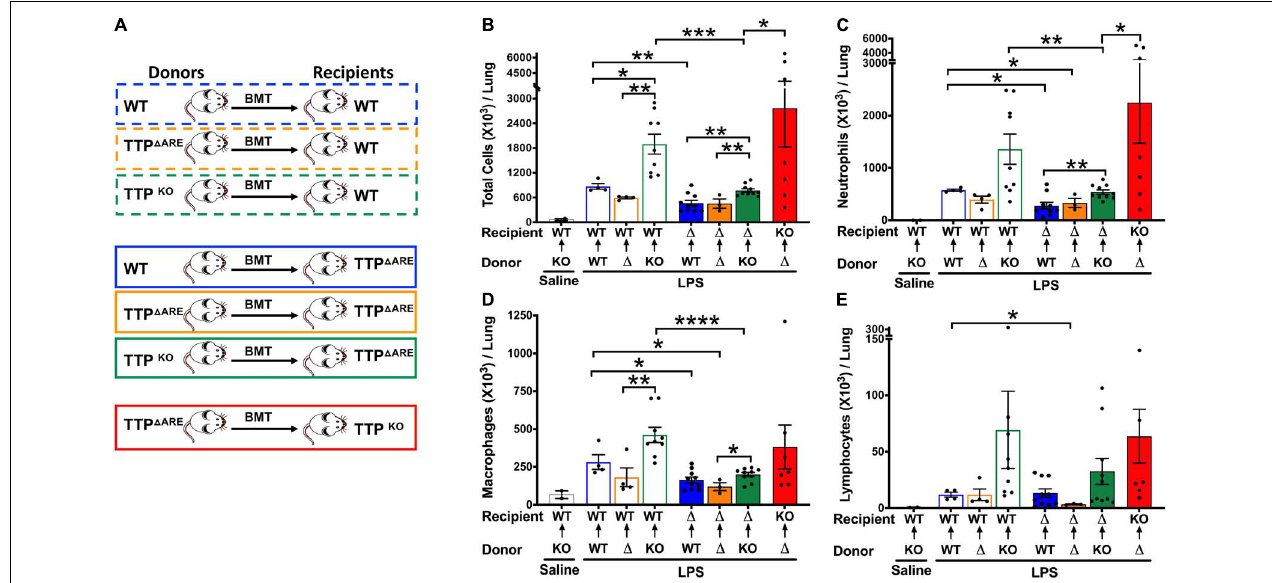
FIGURE 5 | Effect on ALI following bone marrow irradiation and reconstitution of WT, TTP overexpressing (TTP (cid:49) ARE ), and TTP knockout (TTP KO ) mice. Experimental design (A) for bone marrow irradiation and reconstitution experiment followed by LPS-induced ALI. Total cell counts (B) in the BALF from adult recipient WT, TTP (cid:49) ARE , and TTP KO mice post 72 h after LPS-challenge. Open black bar (saline administered recipient WT mice); open blue bar (WT → WT), open orange bar (TTP (cid:49) ARE → WT), open green bar (TTP KO → WT), solid blue bar (WT → TTP (cid:49) ARE ), solid orange bar (TTP (cid:49) ARE → TTP (cid:49) ARE ), solid green bar (TTP KO → TTP (cid:49) ARE ), solid red bar (TTP (cid:49) ARE → TTP KO ). Differential cell counts are shown for neutrophils (C) , macrophages (D) , and lymphocytes (E) . Statistical analysis was performed by one-way ANOVA followed by Tukey’s correction for multiple comparisons within the three recipient groups and Student’s t -test between the three recipient groups. Data are represented as mean ± SEM. N = 2 (saline control); N = 4 (WT → WT), N = 4 (TTP (cid:49) ARE → WT); N = 9 (TTP KO → WT), N = 10 (WT → TTP (cid:49) ARE ), N = 3 (TTP (cid:49) ARE → TTP (cid:49) ARE ), N = 11 (TTP KO → TTP (cid:49) ARE ), N = 7 (TTP (cid:49) ARE → TTP KO ). * p < 0.05, ** p < 0.01, *** p < 0.001, **** p <